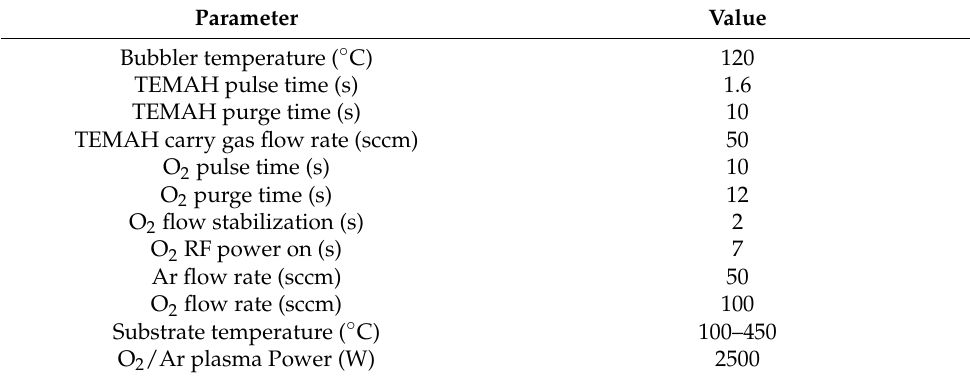
Table 1. Deposition conditions of PEALD HfO 2 thin